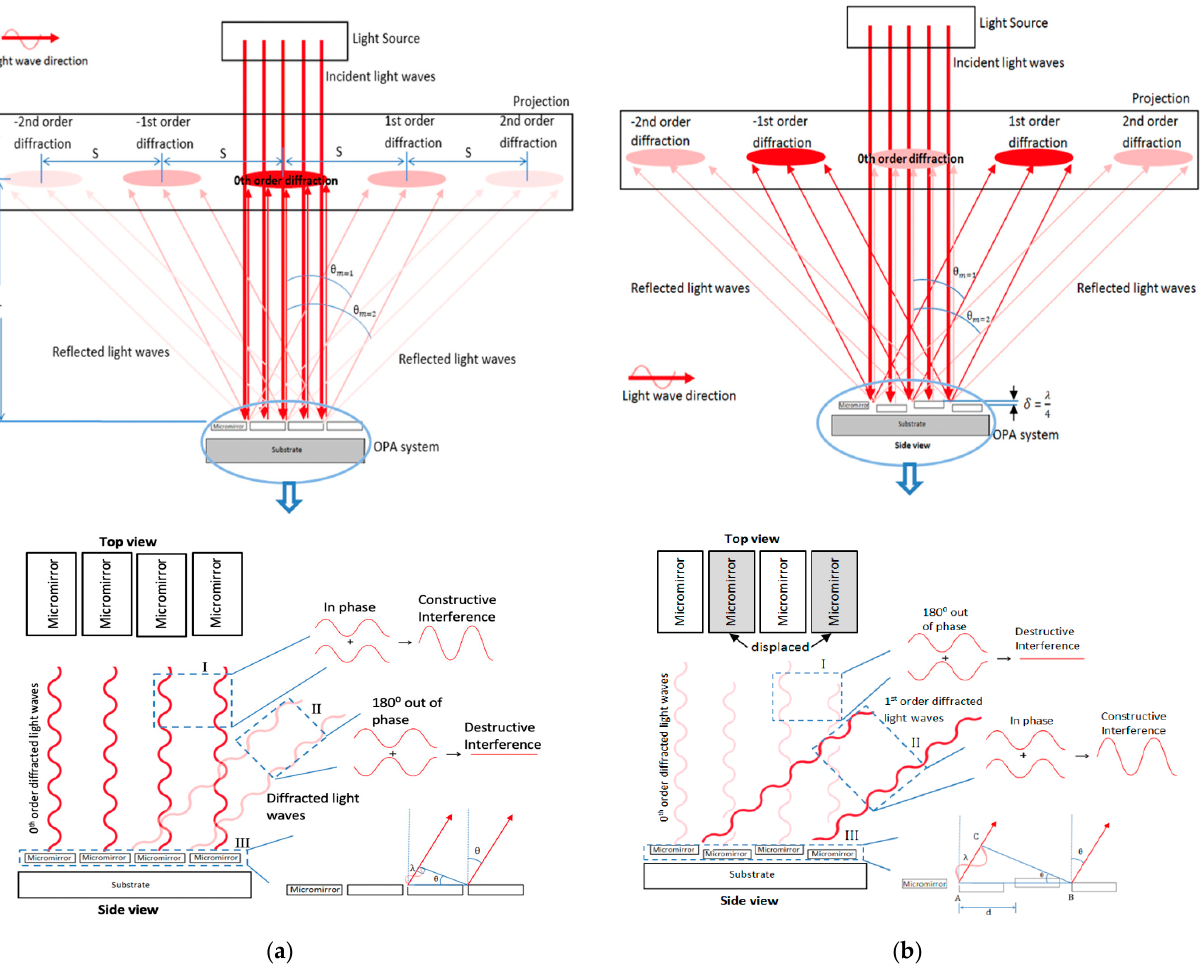
Figure 1. ( a ) Schematic of diffraction profile created by a microelectromechanical system (MEMS)-based optical phased array (OPA) system when illuminated during its unactuated state as incident light waves reflect from the mirror reflective surfaces and through gaps; ( b ) Schematic of illuminated the MEMS-based OPA system as every other suspended micromirror is pulled toward the substrate and the phase of the reflective light wave front is perturbed by setting up an interference